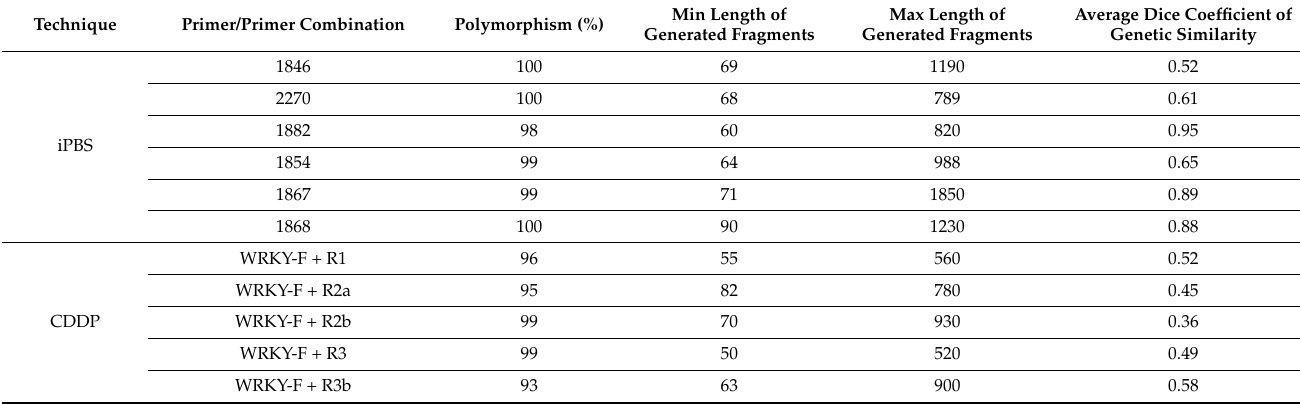
Table 4. Characteristics of fingerprints obtained by iPBS and CDDP